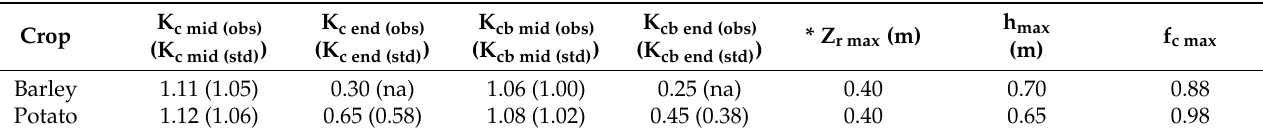
Table 1. Single and basal crop coefficients derived from lysimeter measurements (observed, obs), and adjusted to standard climate (RH min = 45% and u 2 = 2 m s − 1 ) (standard, std) for irrigated barley and potato. K c mid (obs) Crop (K c mid (std) )